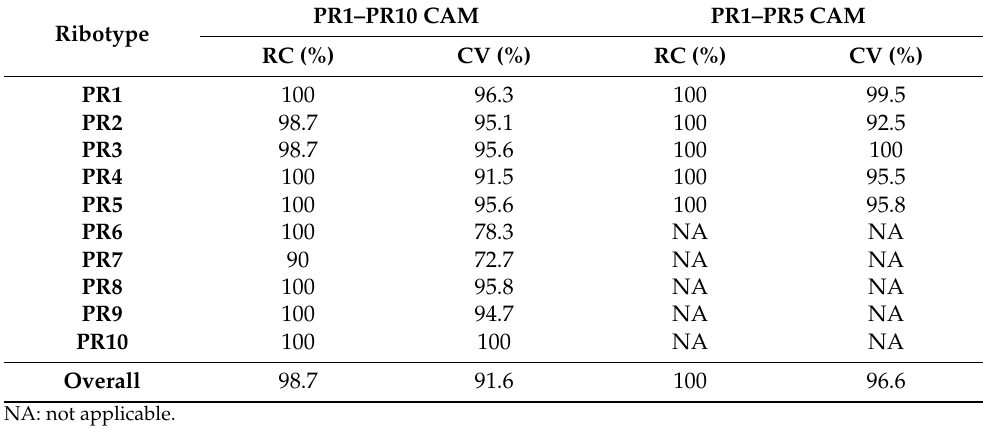
Table 1. Recognition capability (RC) and cross-validation (CV) values of the classifying algorithm model (CAM) able to classify 10 ribotypes (PR1–PR10) and the CAM able to classify the five most frequent ribotypes (PR1–PR5).